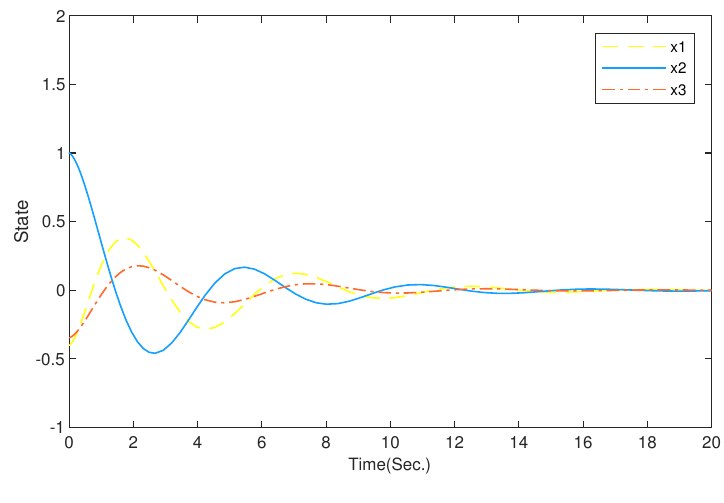
Figure 3. Time response of the closed-loop singular FOS with order α = 3